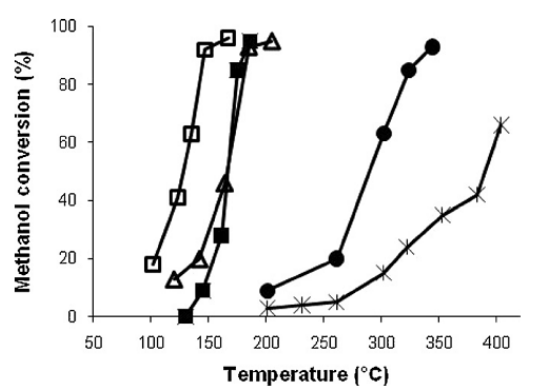
Figure 15. Methanol conversion as a function of reaction temperature for SBA-15 supported catalysts: SBA-15